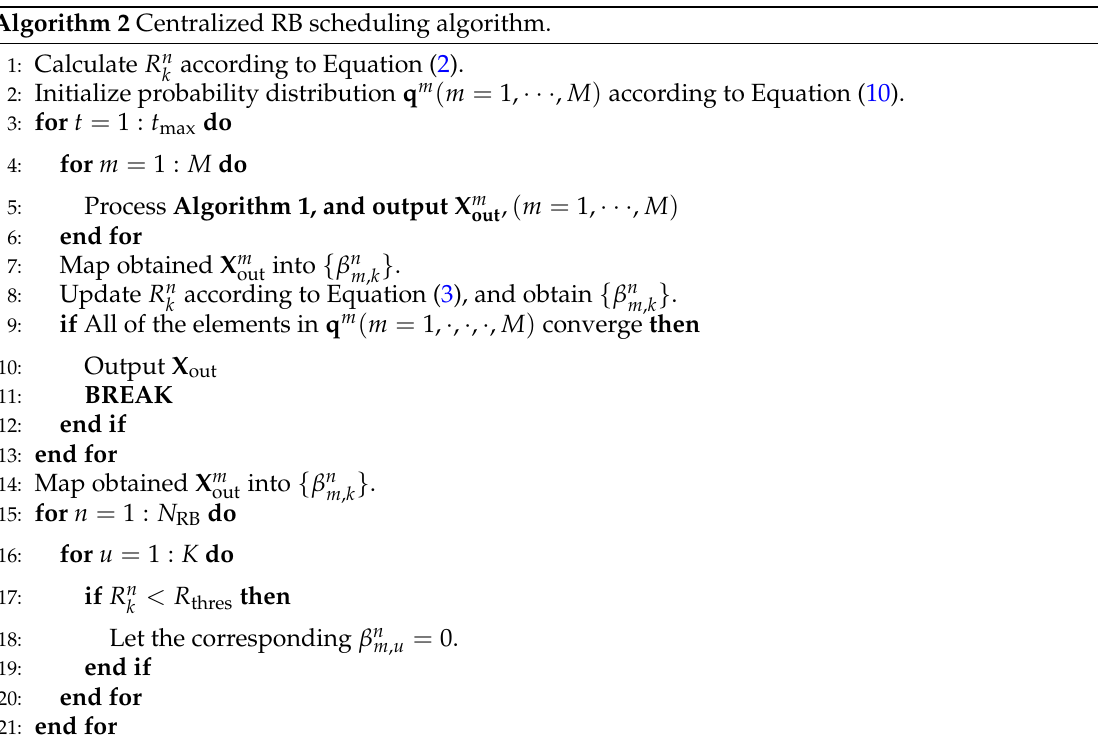
Algorithm 2 summaries the entire RB scheduling algorithm proposed above. Algorithm 2 Centralized RB scheduling